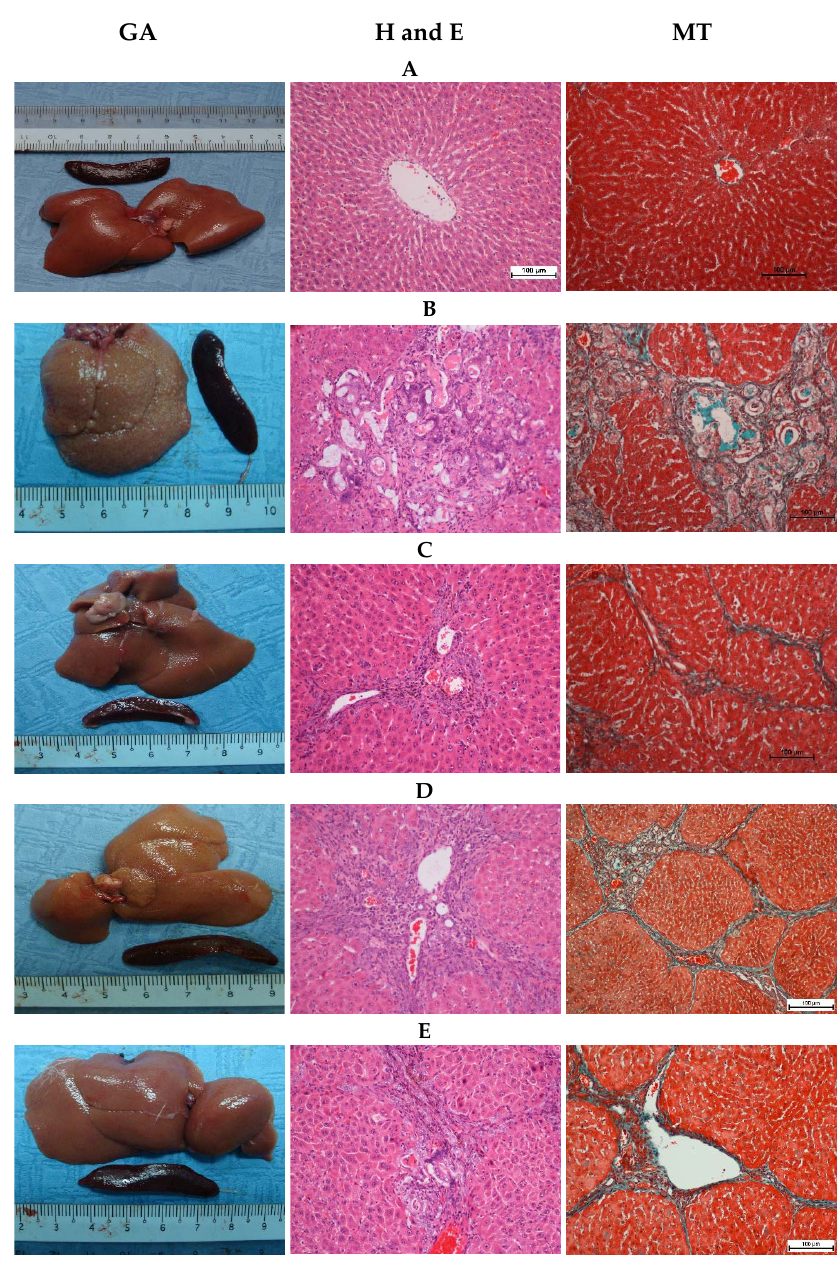
Figure 2. Influences of A. muricata extract on thioacetamide-induced liver injury in experimental rats. ( A ) Normal control group, ( B ) rats treated with thioacetamide (hepatotoxic group), ( C ) rats treated with thioacetamide + silymarin, ( D ) rats treated with thioacetamide + 250 mg/kg A. muricata, and ( E ) Rats treated with thioacetamide + 500 mg/kg A. muricata . (GA) Gross morphology, (H&E) Hematoxylin and Eosin stain 20x, (MT) Masson trichrome stain 20x.